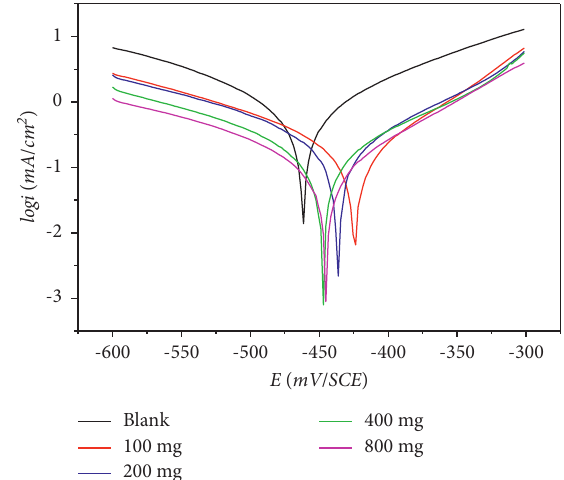
Figure 7: Carbon steel polarization curve in 1M HCl without and with the addition of EEW at